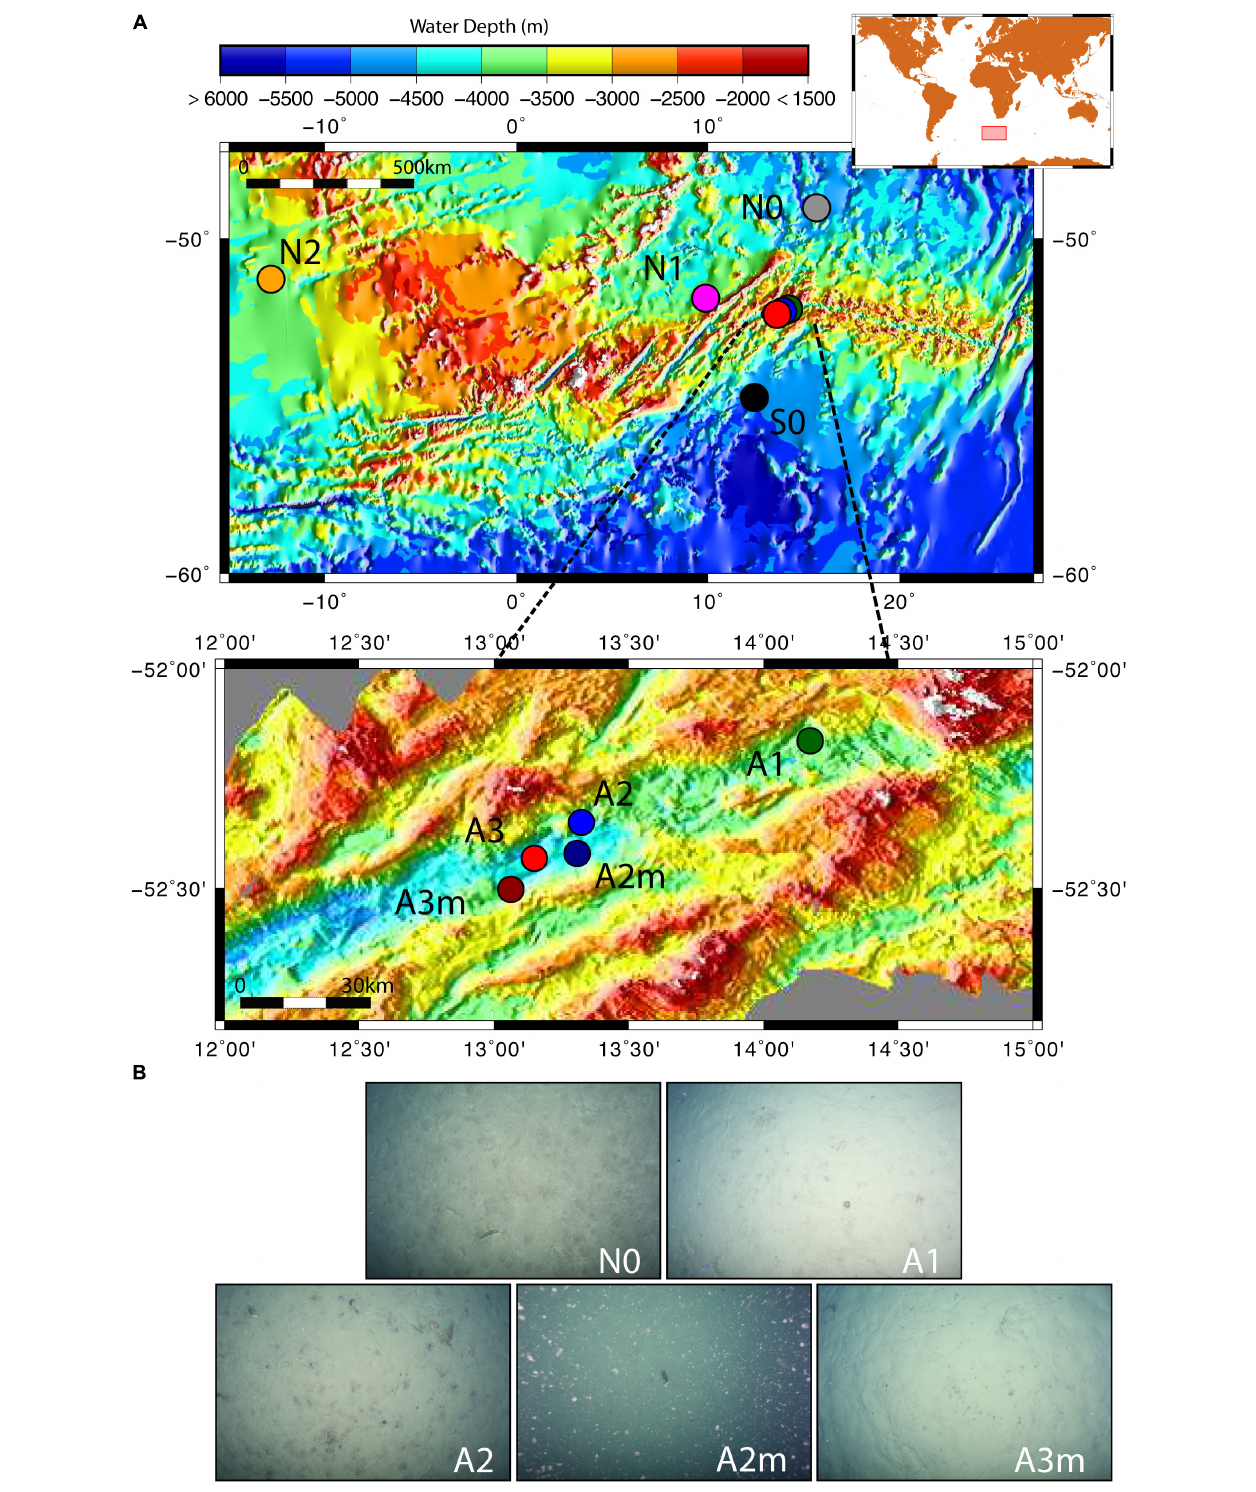
FIGURE 1 | Map of the investigated sites and seafloor pictures. (A) The zoom-in shows the stations inside the Southwest Indian Ridge valley; (B) seafloor photos for station to the north of the SWIR (N0) and for stations inside the SWIR showing diatom ooze sediments; seafloor picture at A2m also shows resuspended sediment particles, which were likely responsible of turbidity signals measured at south ridge flank (Schlindwein, 2014). Green, blue and red dots represent stations inside SWIR, and orange, magenta, gray and black dots represent stations outside SWIR.